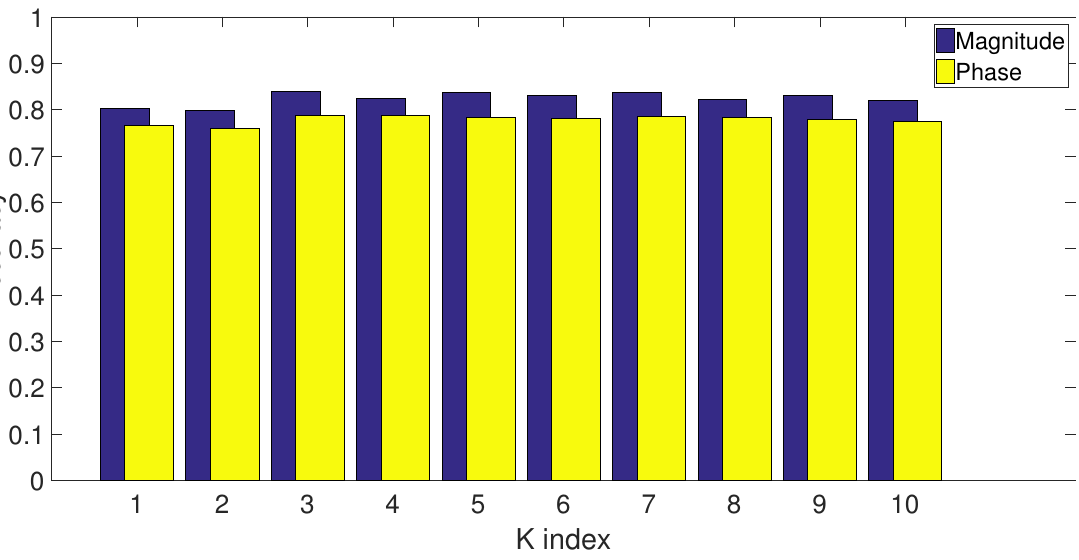
Figure 6. Comparison of the performance accuracy with KNN for the magnitude and phase components of the signal in the time domain for different values of